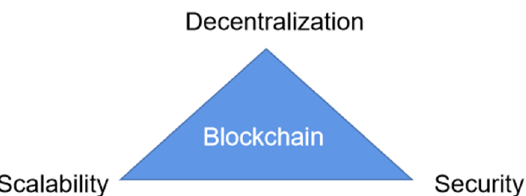
Figure 1. Blockchain trilemma. No current blockchain system can simultaneously achieve decentralization, security and scalability.